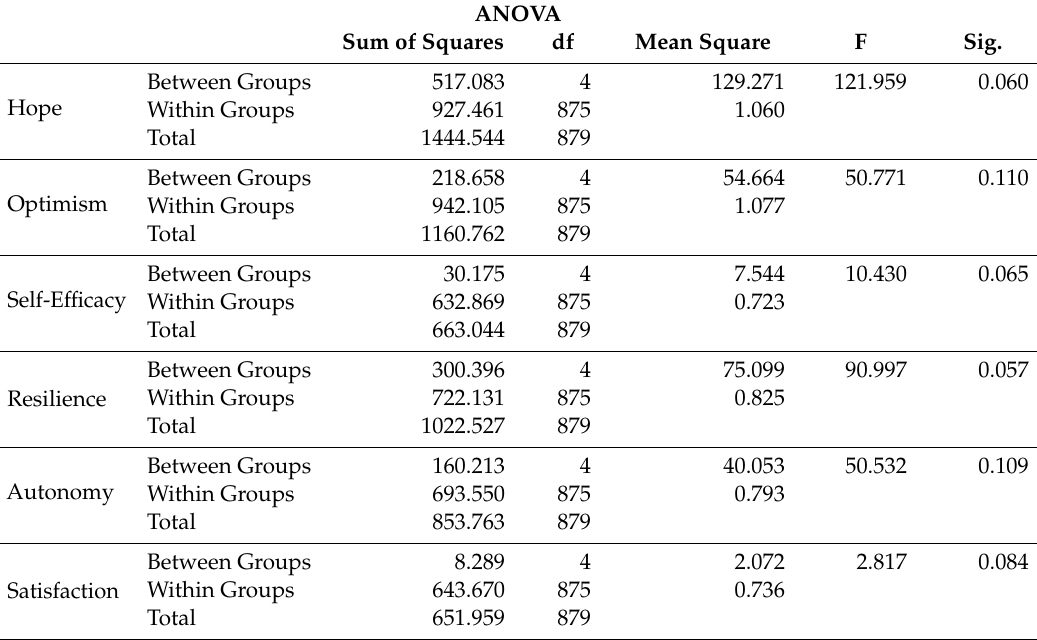
Table 5. Results of ANOVA test of di ff erence of variables between di ff erent occupations.